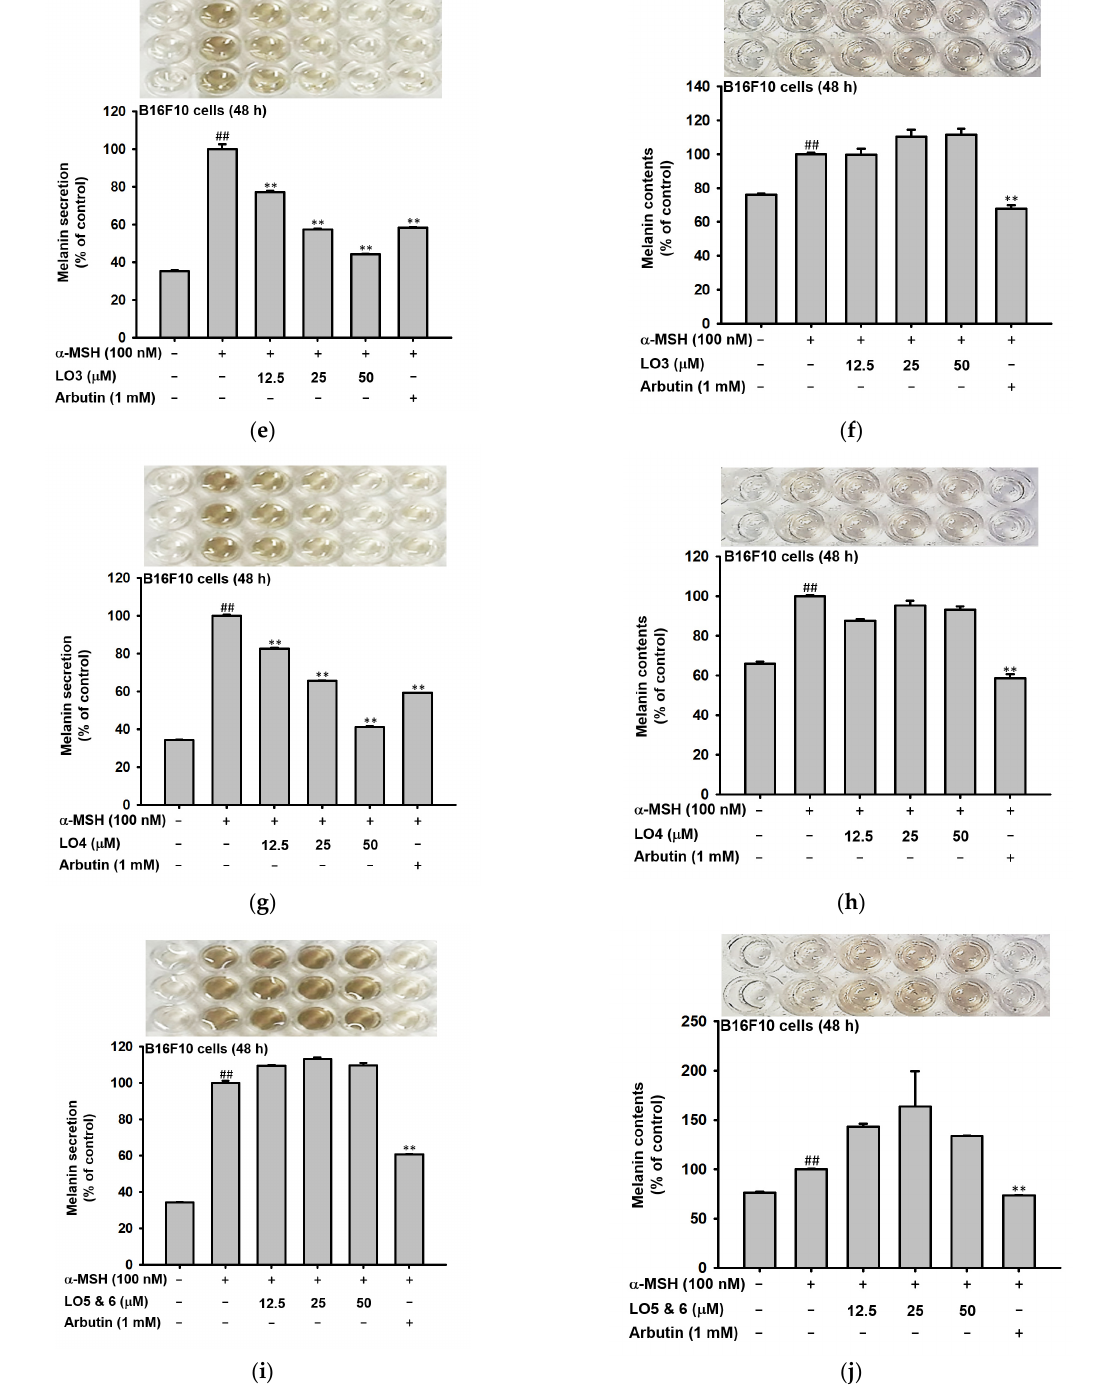
Figure 4. The melanin contents and secretion were detected in B16F10 melanoma cells. ( a – h ) The cells were treated with LO, which includes LO1, LO2, LO3, LO4, and LO5 and 6 with the presence of α -MSH at 48 h. Arbutin, which has been used as a tyrosinase inhibitor, was treated for positive control. After incubating, incubated media supernatants were detected for extracellular melanin at 405 nm ( a , c , e , g , i ). The cell pellets were dissolved by using the solution of 10% DMSO in 1N NaOH. The dissolvents were detected for intracellular melanin at 475 nm ( b , d , f , h , j ). Values represent the mean ± standard deviation (SD) of three independent experiments. # p < 0.05 and ## p < 0.01 compared with normal via Mann-Whitney U test. * p < 0.05 and ** p < 0.01, compared with α -MSH- treated group via Mann-Whitney U